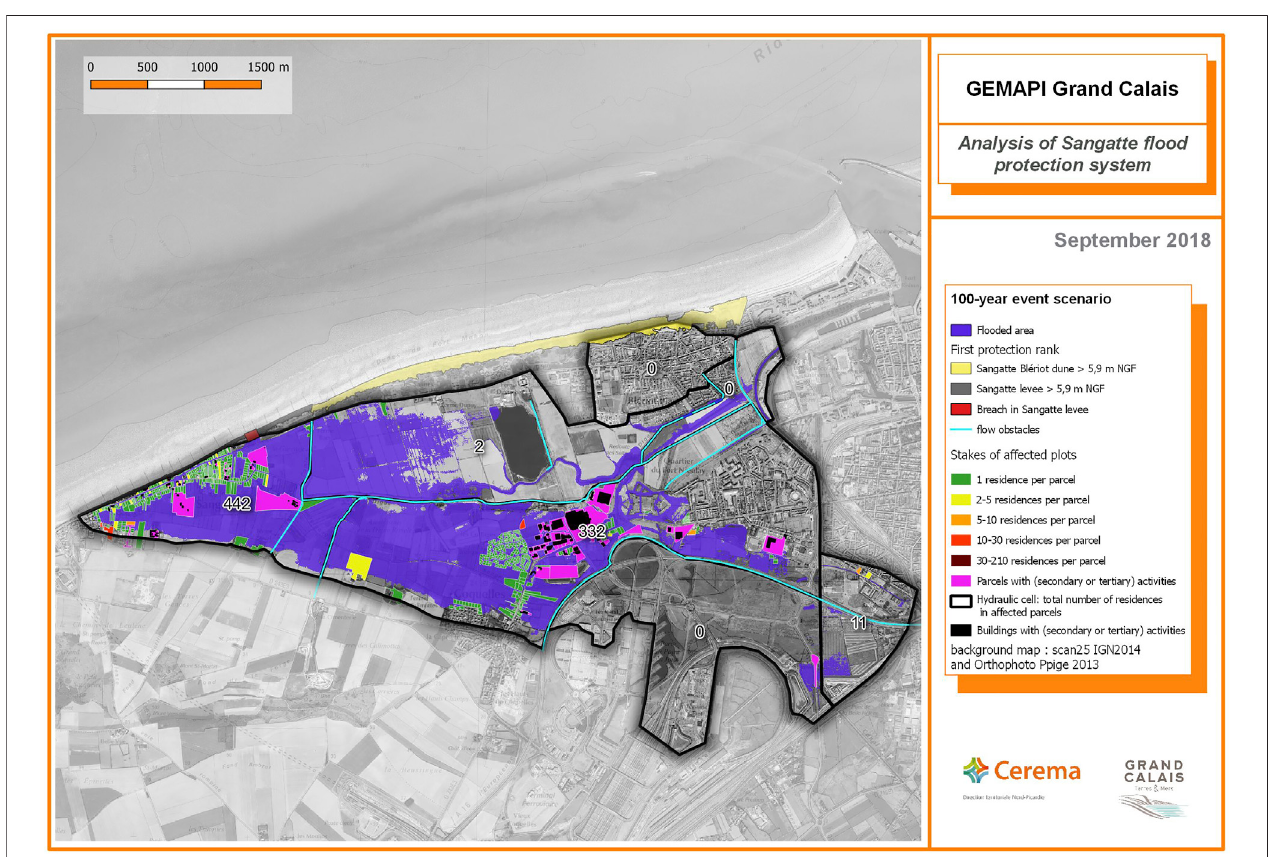
FIGURE 1 | Flood risk analysis in the municipality of Sangatte (Cerema, 2020). Credit: Kevin Corsiez, Bruno Kerloc ’ h, Cerema.